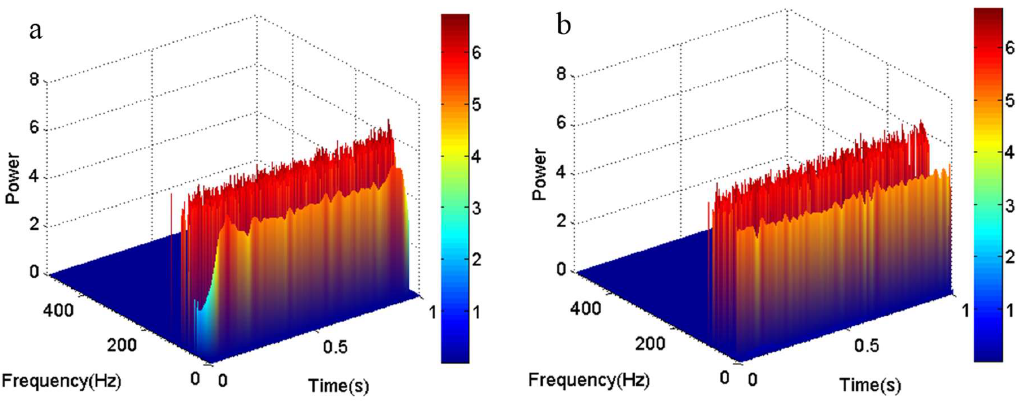
Figure 5. The three-dimensional time-frequency-power spectrum. ( a ) The three-dimensional time-frequency-power spectrum obtained by the original EMD method; ( b ) The three-dimensional time-frequency-power spectrum obtained by the local linear extrapolation method.